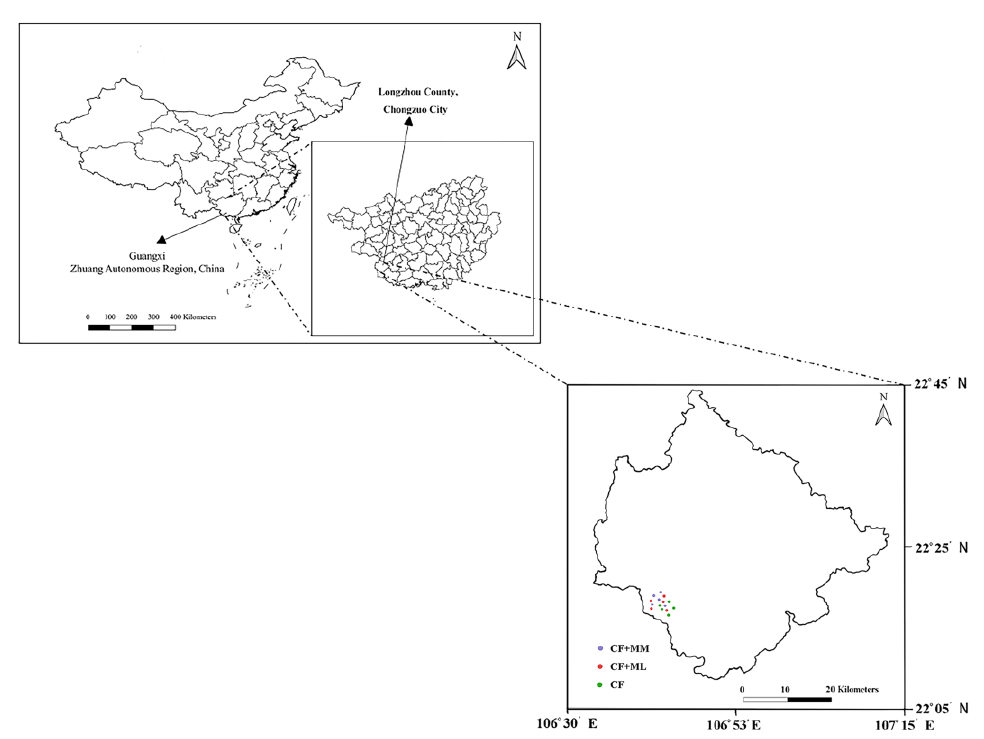
Figure 1. Location of the study site. (CF + MM stands for mixed plantation of Chinese fir ( Cunning- hamia lanceolata (Lamb.) Hook) and Michelia macclurei Dandy. CF + ML stands for mixed plantation of Chinese fir and Mytilaria laosensis Lecomte. CF stands for pure plantation of Chinese fir).